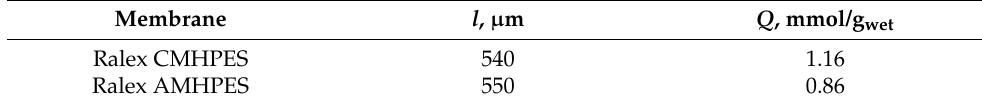
Table 1. The physical-chemical properties of IEM.